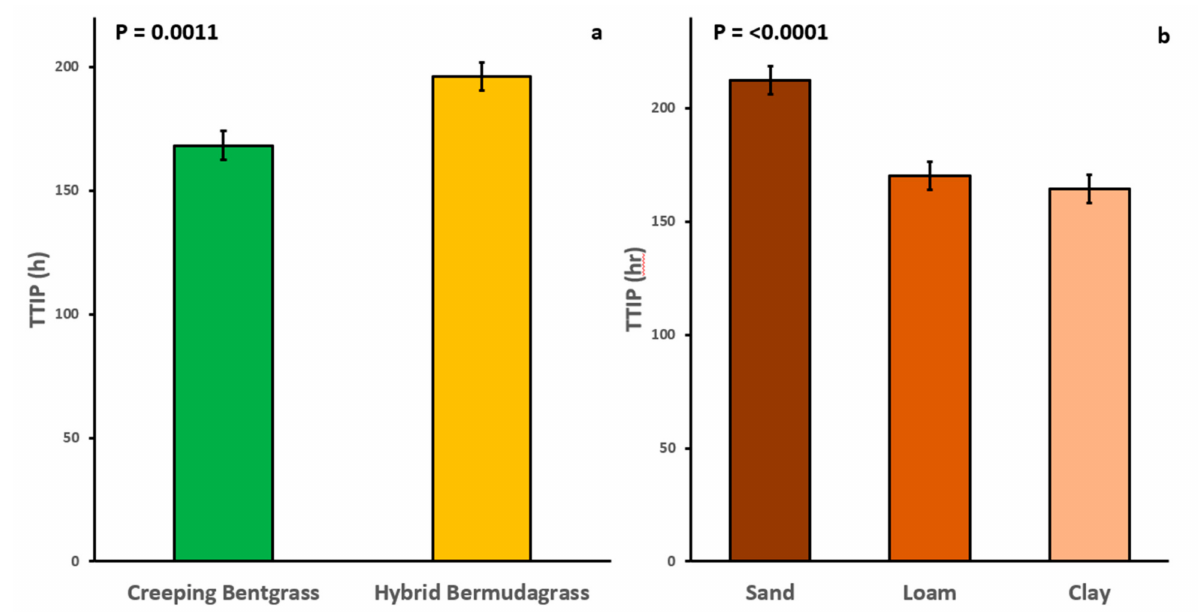
Figure 3. Mean time (hours) to reach the inflection point (TTIP) of creeping bentgrass and hybrid bermudagrass grown in three soil textures subjected to drought stress under greenhouse conditions in Blacksburg, VA across six-dry down cycles. The inflection points of the water band index (WBI = R 900 /R 970 ) and the green-to-red ratio index (GRI = R 550 /R 670 ) were used to identify hours from the initiation of the dry-down cycle until IP. Inflection points were modeled using a non-linear four-parameter logistic regression of spectral reflectance data and pooled across ( a ) WBI, GRI, and soil types ( b ) WBI, GRI and grass